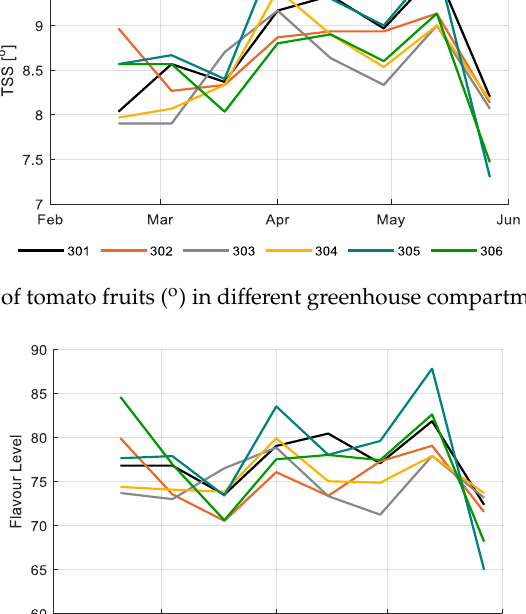
Table 2. Resource use efficiency (unit resource used per kg tomato produced) for different teams and their crop in different greenhouse compartments during the experimental period, heat (MJ/kg), electricity (kWh/kg), CO 2 (kg/kg), water (l/kg), and nutrients (g/kg).